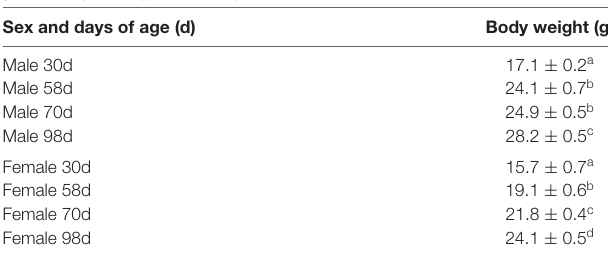
TABLE 1 | Mean ( ± SEM) body weight of male and female mice in Experiments 1 (male mice) and 2 (female